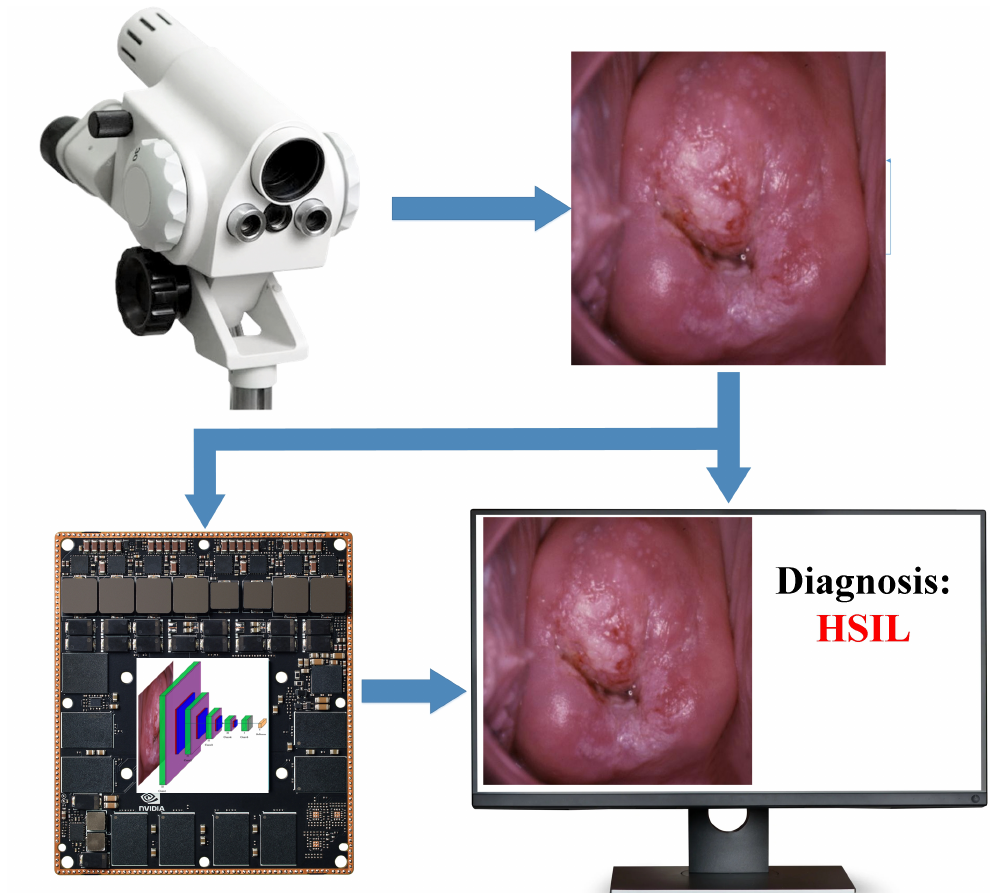
Figure 7. Illustration of the application of the developed